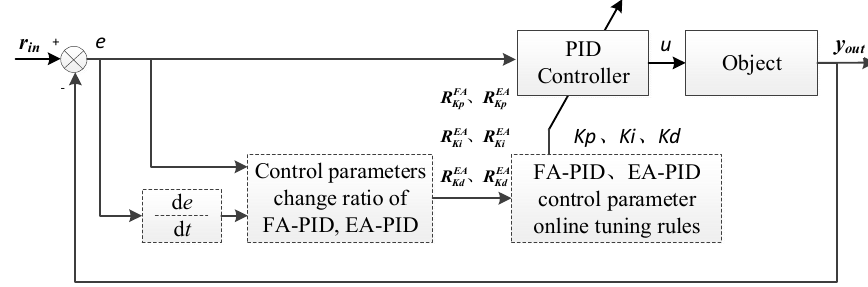
Figure 4. System structure of EA-PID (Definition 3) and FA-PID (Definition 4) methods.